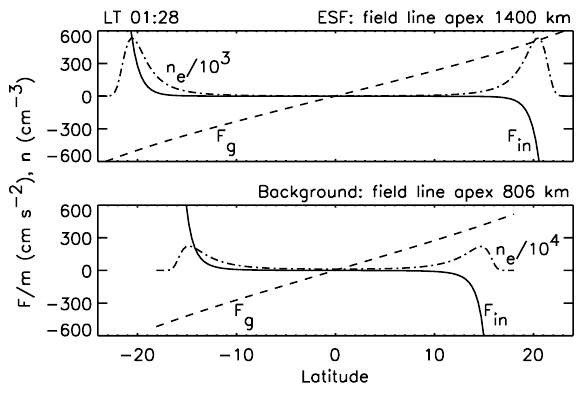
Fig. 2. Field-aligned gravity ( F g , dashed line) and diffusion ( F in , solid) forces acting on O + ions are indicated within the ESF plume (top panel) and in the background ionosphere (bottom panel) for field lines corresponding to the ionization crests in each case. Elec- tron density (dot-dash) is also plotted.